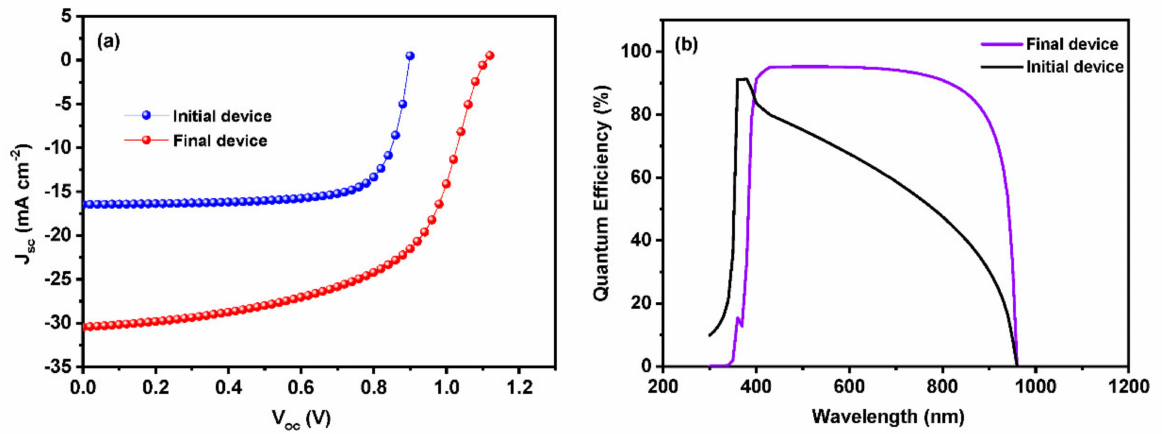
Figure 9. ( a ) J-V curves and ( b ) external quantum efficiency of initial and final device based on ZnO ETL.